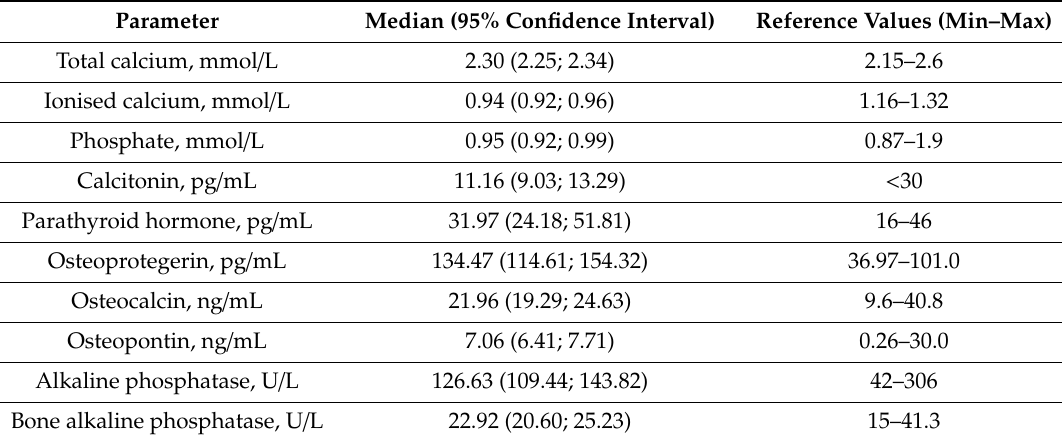
Table 2. Biochemical parameters regulating mineral homeostasis measured before the CABG surgery ( n =